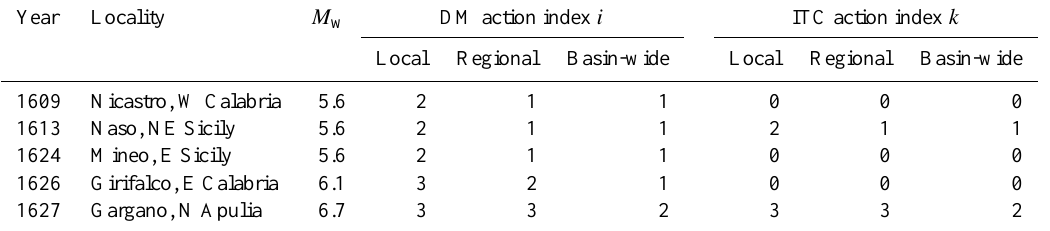
Table 6. Comparison between DM action and ITC action indexes for some events that occurred soon after 1600AD, which is the time threshold selected in the present analysis. Before this date, both the CPTI04 and the ITCver3 are largely